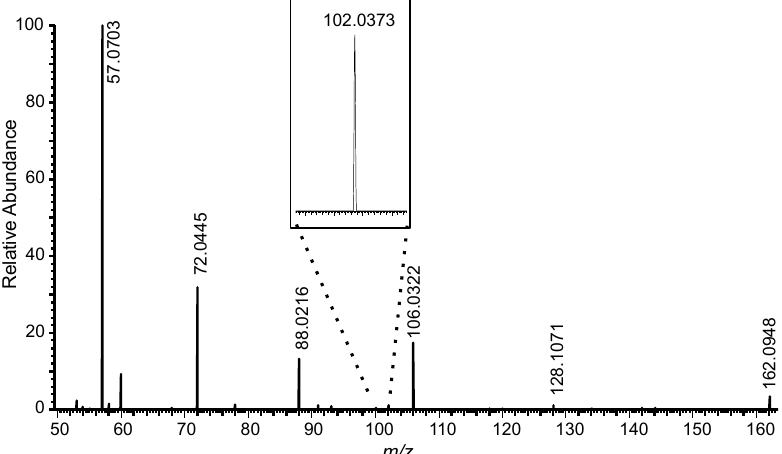
Figure 2. CID/HCD MS/MS spectrum of the selected ion at m/z 162 product ion of pebulate. The insert is the zoom region showing ion at m/z 102.